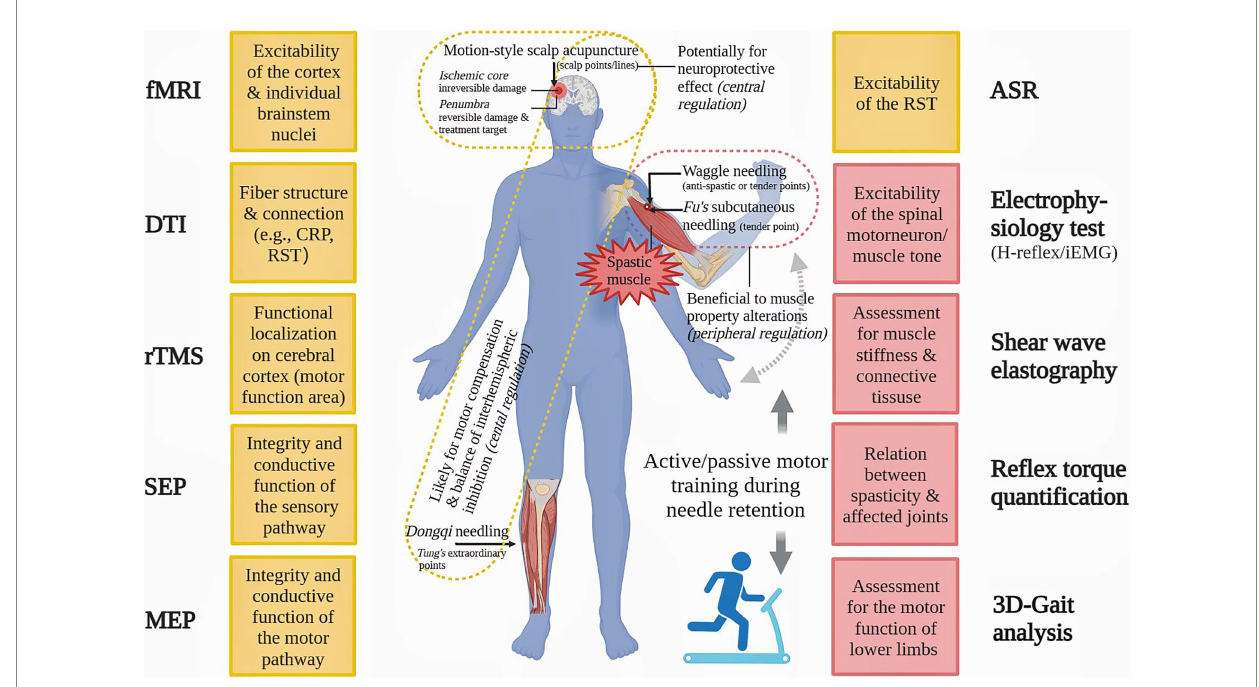
FIGURE 2 Advanced methods for spasticity assessment and their potential application in future motion-style acupuncture research. ASP: acoustic startle reflex, CRP: corticoreticular pathway, DTI: diffusion tensor imaging, fMRI: functional magnetic resonance imaging, iEMG: integrated electromyography, MEP: motor evoked potential, rTMS: repetitive transcranial magnetic stimulation, RST: reticulospinal tract, SEP: somatosensory evoked